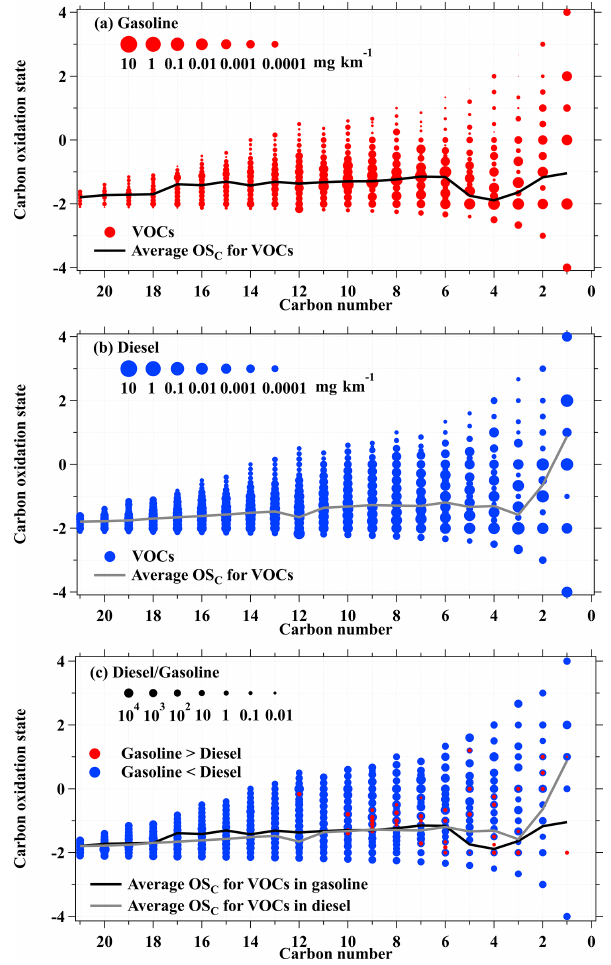
Figure 6. The two-dimensional space of OS C − n C with data points sized coded using emission factors of VOC species from (a) gaso- line and (b) diesel vehicles, as well as (c) the ratio of emission fac- tors of diesel vehicles relative to gasoline vehicles. The black and gray lines are the average OS C of each carbon number for VOC species in gasoline and diesel vehicles,